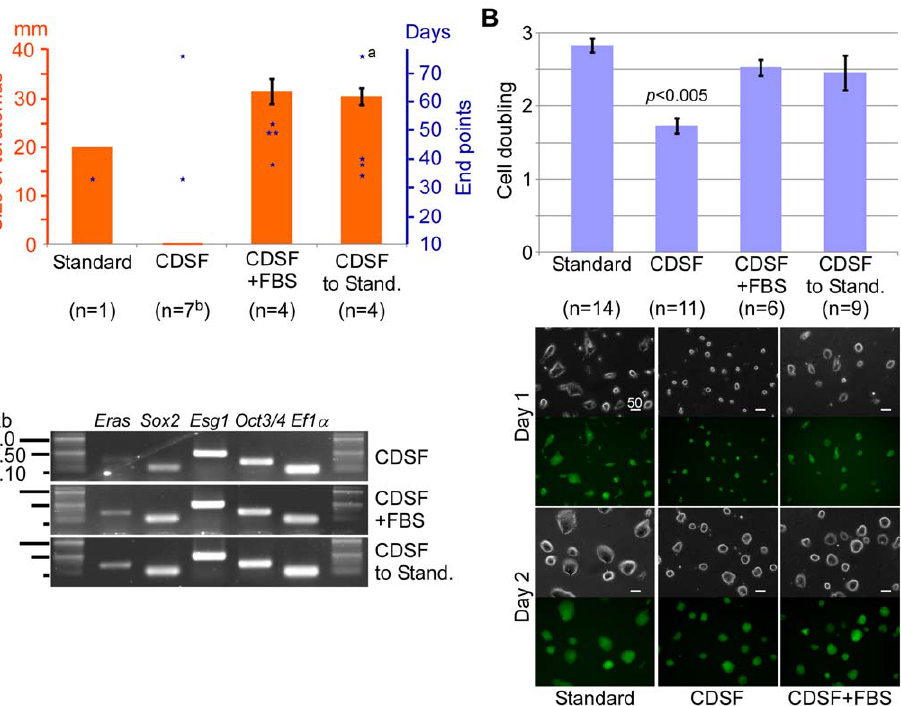
Figure 4. Phenotypic changes observed in mouse embryonic stem cells cultured under CDSF conditions. (A): The sizes of the teratomas formed (orange bar, left axis) and the number of days required for the experimental NOD-SCID mice to reach their end points (blue stars, right axis) were compared among mESCs cultured under the conditions indicated (see Fig. 1A). Parentheses indicate the number of biological replicates (i.e., mESCs prepared at different passages) per culture condition. Standard errors of the means are indicated by bars. a : Only one passage in standard conditions followed CDSF culture. b : Two out of seven transplantations showed no sign of teratoma formation when paired with the standard and CDSF-Standard conditions, whereas five out of seven transplantations showed no sign of teratoma formation for 6 months. (B, top): Cell doublings were measured every 48 hours after plating 1 6 10 6 cells per well onto 6-well plates (see Materials and Methods for the formula). Only CDSF conditions produced statistically-significant differences compared to standard conditions. Parentheses indicate the number of biological replicates per condition. Standard errors of the means are indicated by bars. (B, bottom): Phase contrast (top) and fluorescence (bottom) images are shown for the Oct3/4::EGFP mESC line (Fig. 1A) grown under the conditions indicated below 1 and 2 days after plating 0.1 6 10 6 cells per well in 6-well plates. Bars, 50 m m. (C): Abundance of each transcript indicated above was examined in mESCs cultured under each condition on the right by 25 cycles of PCR. Ef1 a was used as a reference.